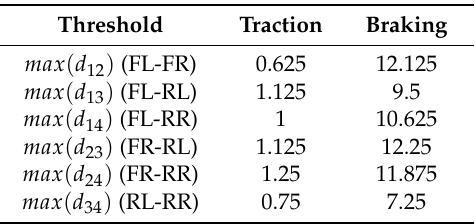
Table 5. Threshold selection of Threshold